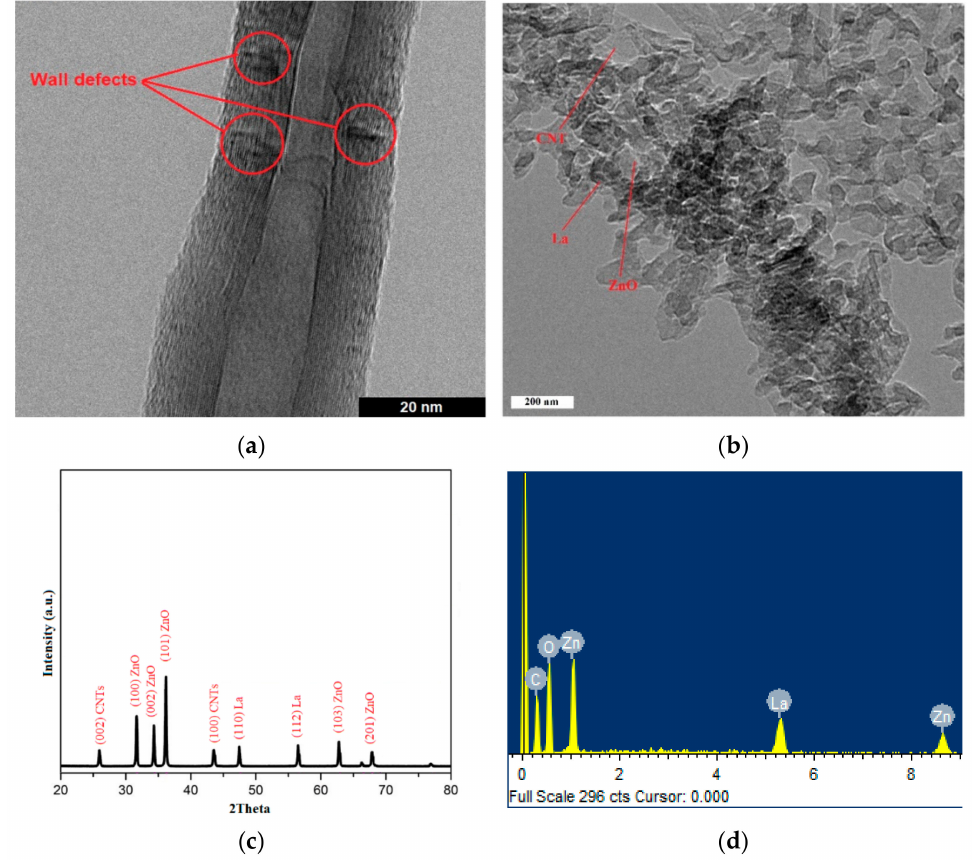
Figure 4. ( a ) TEM morphology of pristine CNTs; ( b ) TEM morphology of La/ZnO/CNTs composite; ( c ) XRD pattern of La/ZnO/CNTs composite; and ( d ) EDX pattern of La/ZnO/CNTs composite